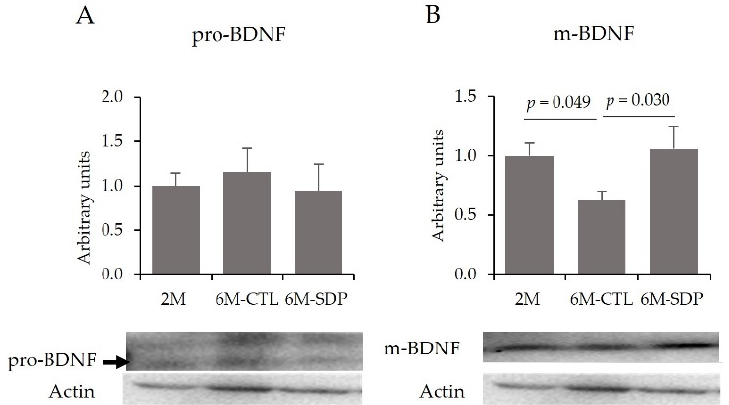
Figure 4. Abundance of BDNF precursor (pro-BDNF) ( A ) and mature BDNF (m-BDNF) ( B ). Results are expressed as mean ± SEM ( n = 5 − 6 mice/group). Statistics: ANOVA (Fisher multiple comparison test), and chi-square test.